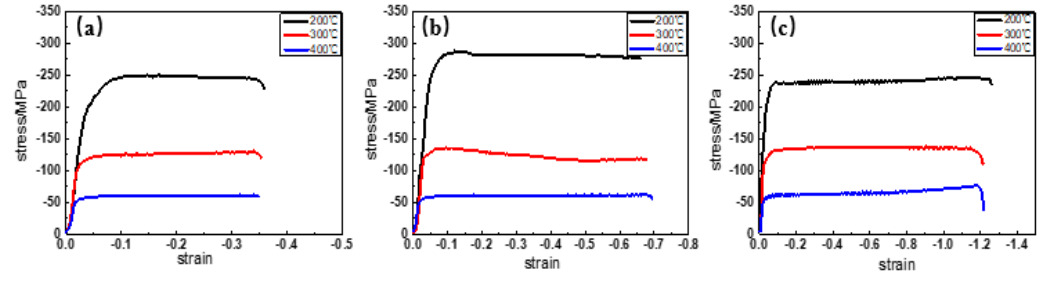
Figure 2. 6082-T6 compression true stress–strain curves ( a ) 30%; ( b ) 50%; ( c ) 70%.